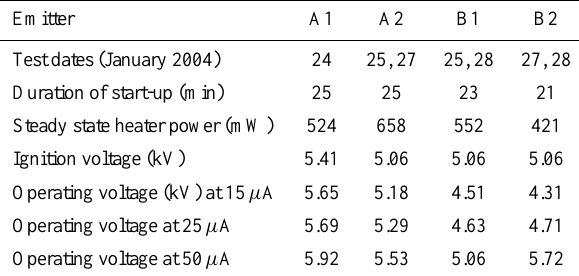
Table 2. Summary of commissioning